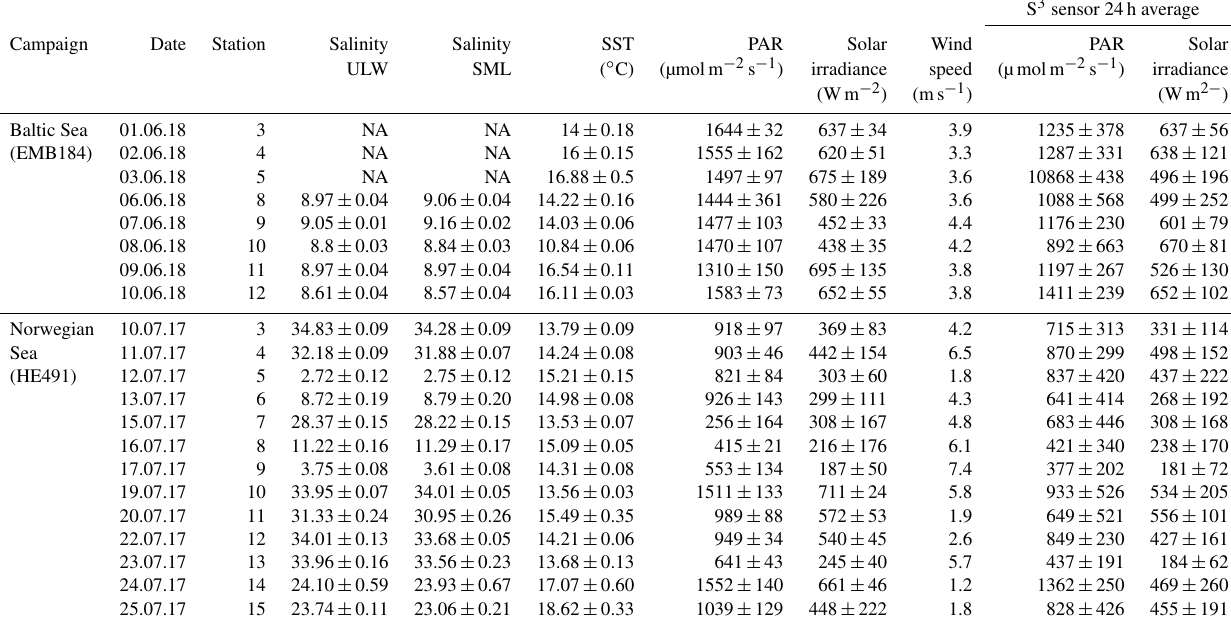
Table 1. S 3 data with averages ± standard deviation, from 2h surrounding discreet sampling, and 24h average for PAR and solar irradiance data. HE491 station 7 was sampled in morning compared to the rest, which were sampled in afternoon. NA – not